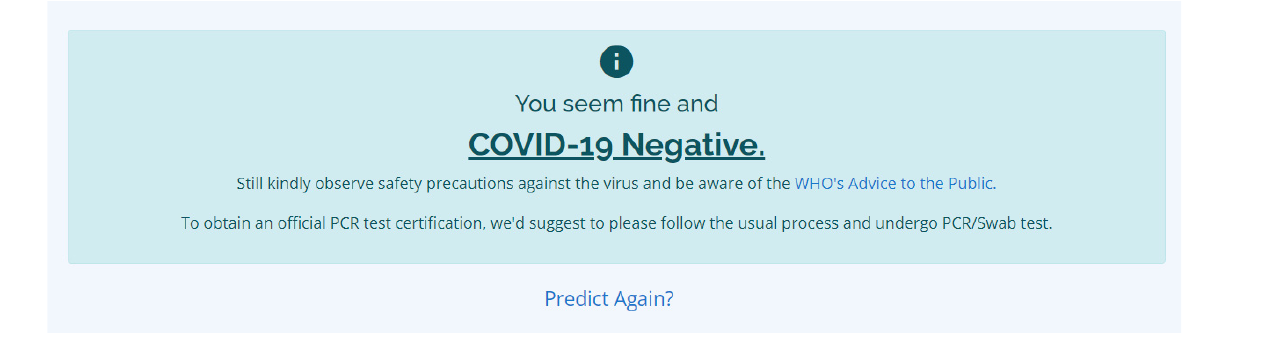
Figure 12. The notification for the COVID-19 Negative result.